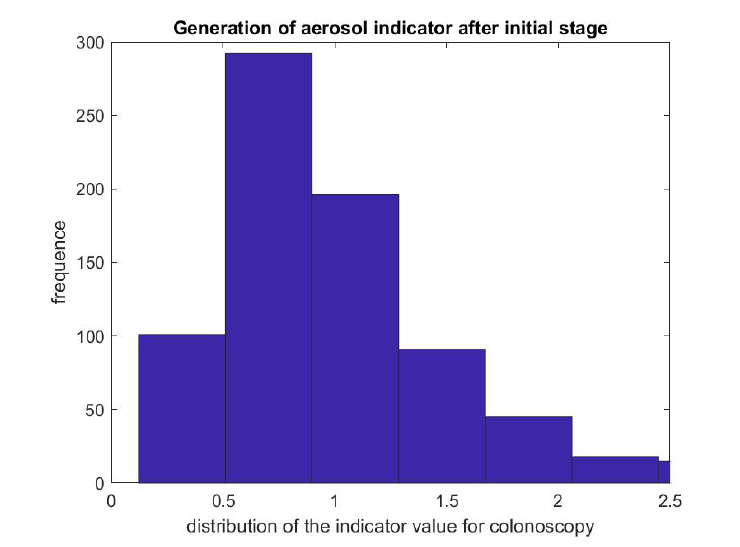
Figure 9. Indicator of aerosol generation for a colonoscopy after the initial phase. The figure represents the distribution of the ratio P col =